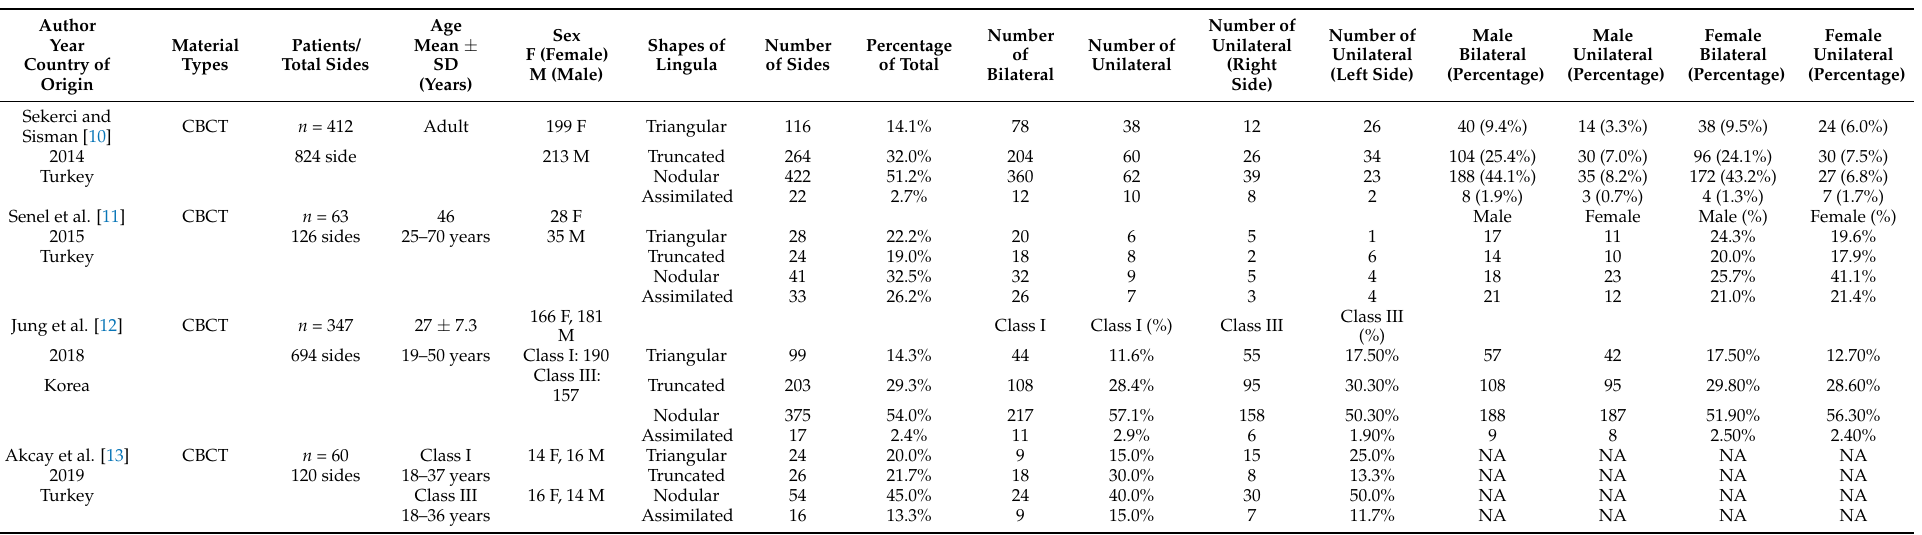
Table 2. Demographic and study characteristics in the included studies (Cone-beam computed tomography: